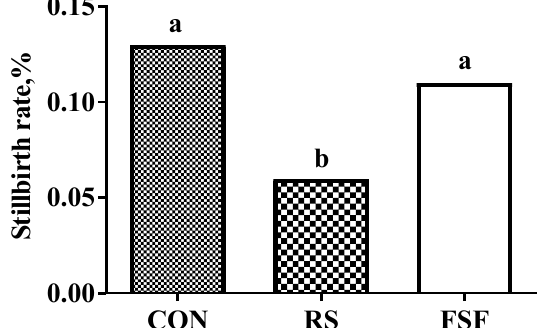
Figure 1. Effect of inclusion of resistant starch (RS) or fermented soybean fiber (FSF) in gestation diet on stillbirth rate. CON = control diet group; RS = 5% resistant starch diet group; FSF = 5% fermented soybean fiber diet group. Stillbirth rate was analyzed using the Chi-square. test. a,b Means with different superscripts within a row differ significantly ( p < 0.05).